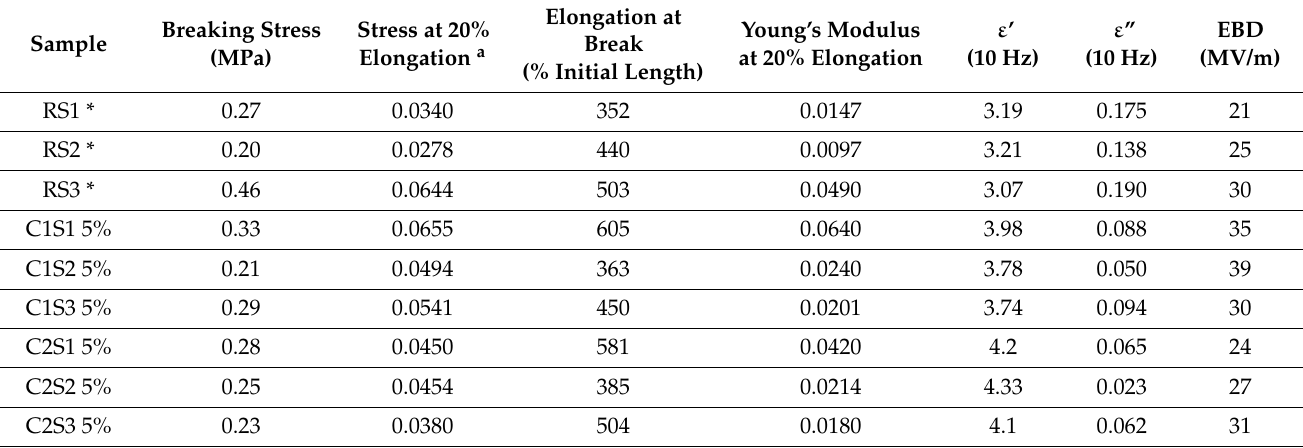
Table 2. Mechanical and dielectric properties of the dielectric elastomers.